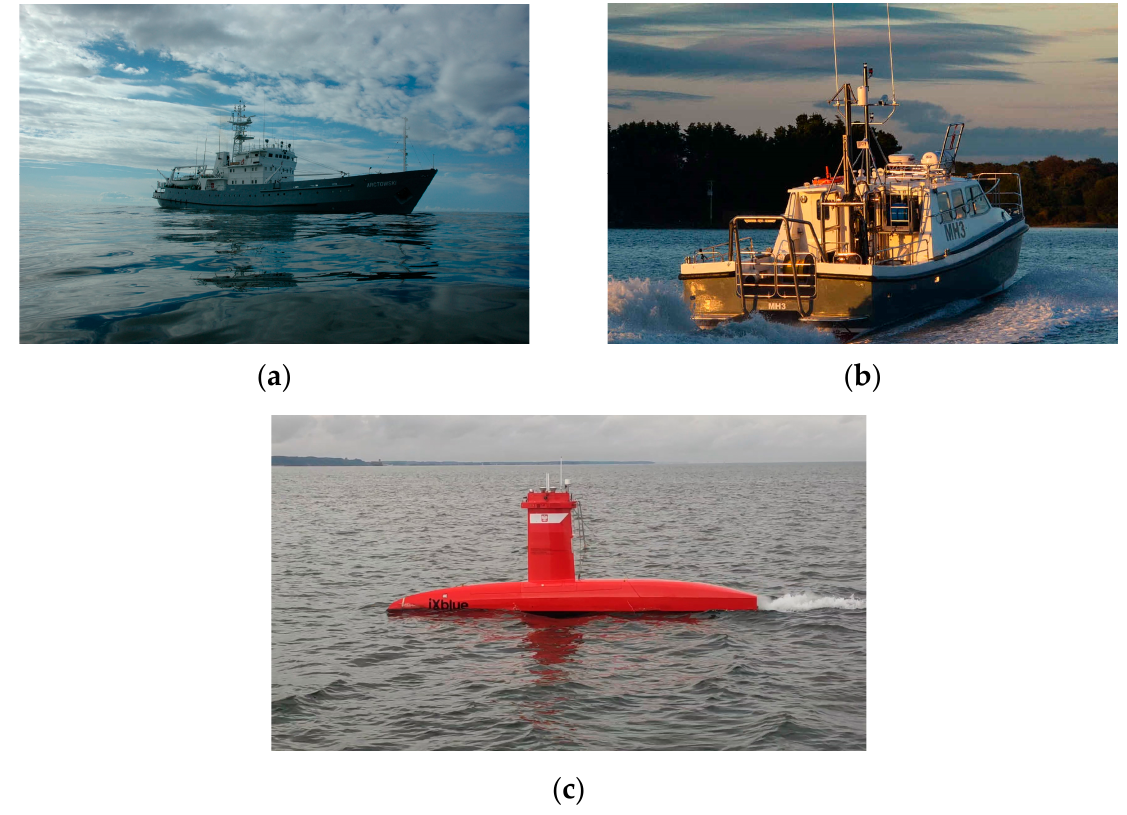
Figure 3. The platforms used in the study, from the left: ( a ) ORP Arctowski survey ship, ( b ) Wildcat catamaran, and ( c ) DriX drone. Sources: K. Jaskólski.